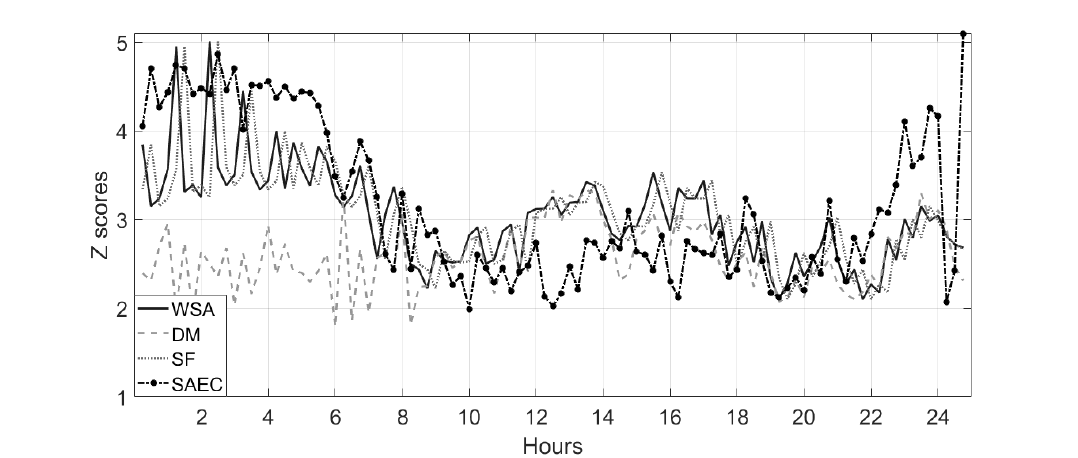
Figure 10. Maximum Z score of the consumption pattern.